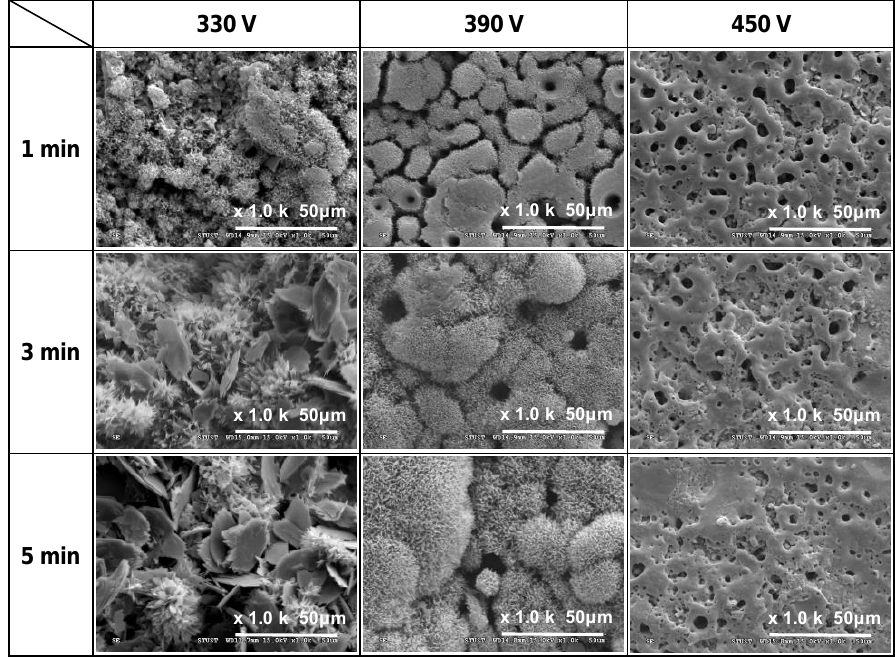
Figure 3. Surface morphologies of MAO coatings prepared with different applied voltages and duration times and constant applied current of 0.6